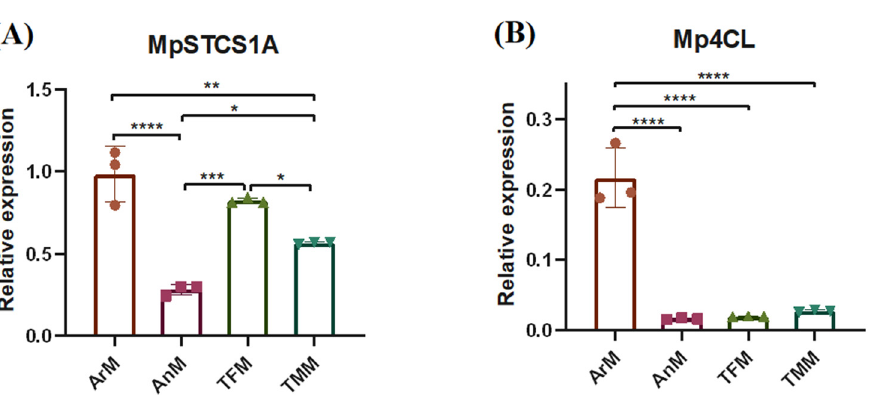
Figure 3. Expression patterns analysis of key genes involved in bibenzyl biosysthesis in four parts of M. polymorpha . ( A ) The expression level of MpSTCS1A in four tissues of M. polymorpha . ( B ) The expression level of Mp4CL in four tissues of M. polymorpha . Values are presented as mean ± standard deviation of three replications. Analysis of variance (ANOVA) and multiple range test (Tukey’s test) indicated significant differences. * p < 0.05, ** p < 0.01, *** p < 0.001, **** p < 0.0001.